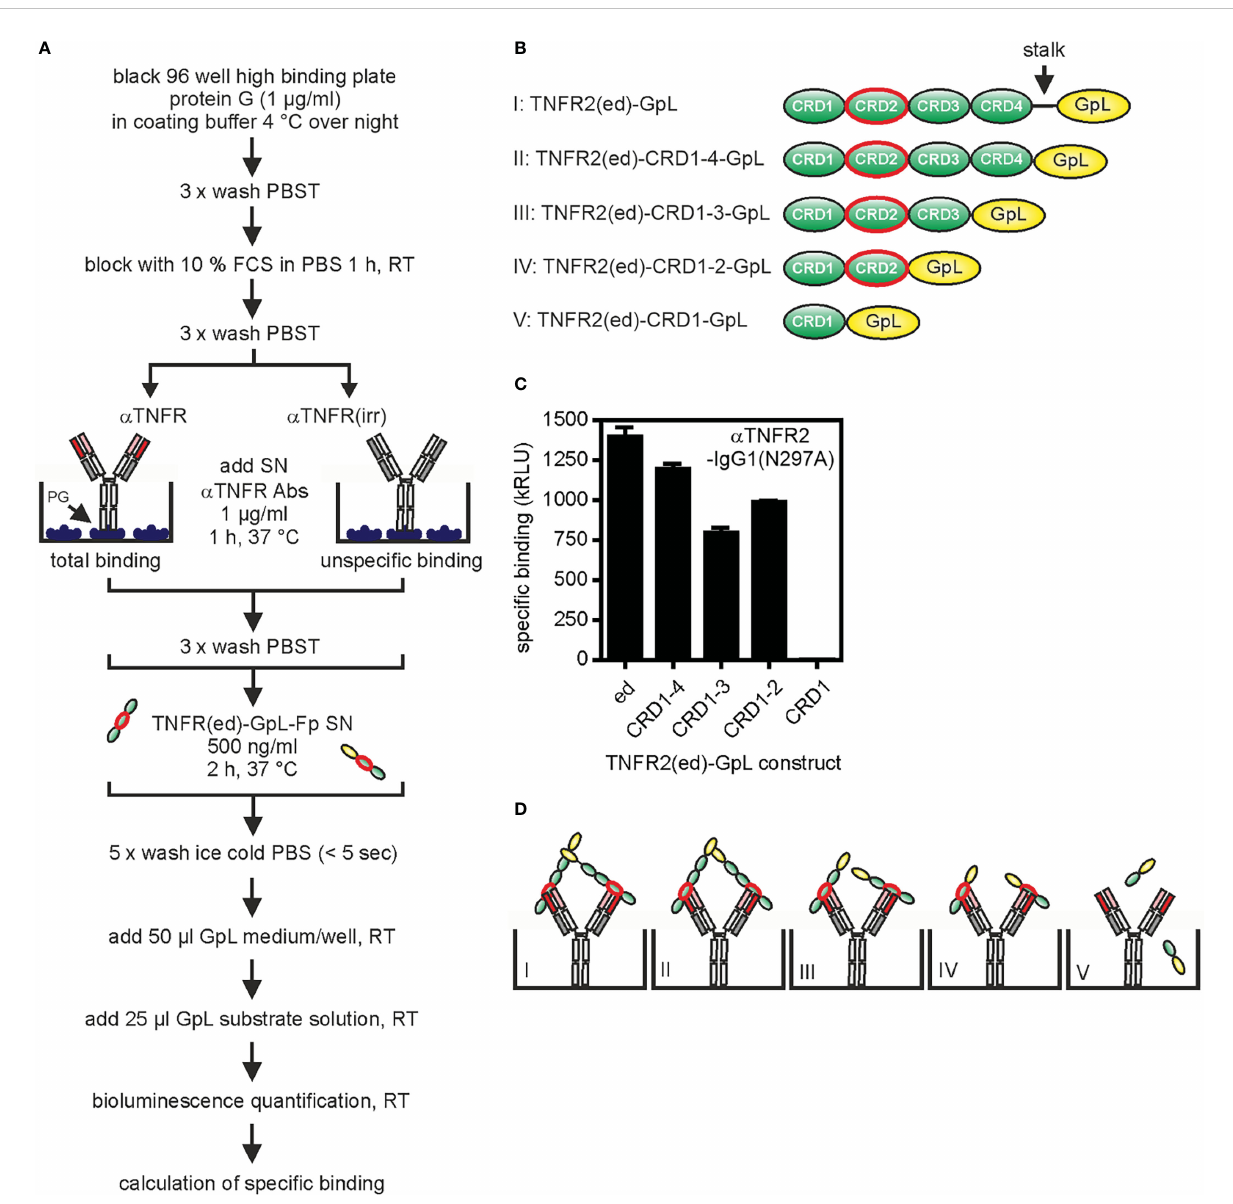
FIGURE 3 Epitope mapping for the anti-TNFR2 antibody 68/69 using TNFR-GpL fusion proteins. (A) Process chart of the method. (B) Schemes of the domain architecture of TNFR2(ed)-GpL fusion proteins used. The cysteine rich domain 2 (CRD2) of TNFR2 is circled in red. (C) Black 96 well high binding plates were coated with 1 µg/ml protein G (PG) in coating buffer at 4°C overnight. Next day, anti-TNFR2(68/69)-IgG1(N297A) or an irrelevant IgG1 were bound to the immobilized protein G by incubation for 1 h at 37°C. After removal of unbound proteins, 500 ng/ml of the various TNFR2-GpL fusion proteins were added (2 h, 37°C). Finally, unbound molecules were removed and well-associated luminescence was measured. Speci fi c binding of the TNFR2 deletion mutant molecules was obtained by subtraction of the unspeci fi c binding values (irr. IgG1 wells) from the total binding values (anti-TNFR2(68/69)-IgG1(N297A) wells) of the relevant TNFR2(ed)-GpL fusion proteins. GpL medium: RPMI 1640 medium supplemented with 0,5% fetal calf serum (FCS); GpL substrate solution: 1,5 µM coelenterazine in PBS. (D) Scheme of the interaction of the various TNFR2-GpL fusion proteins with PG-immobilized anti-TNFR2